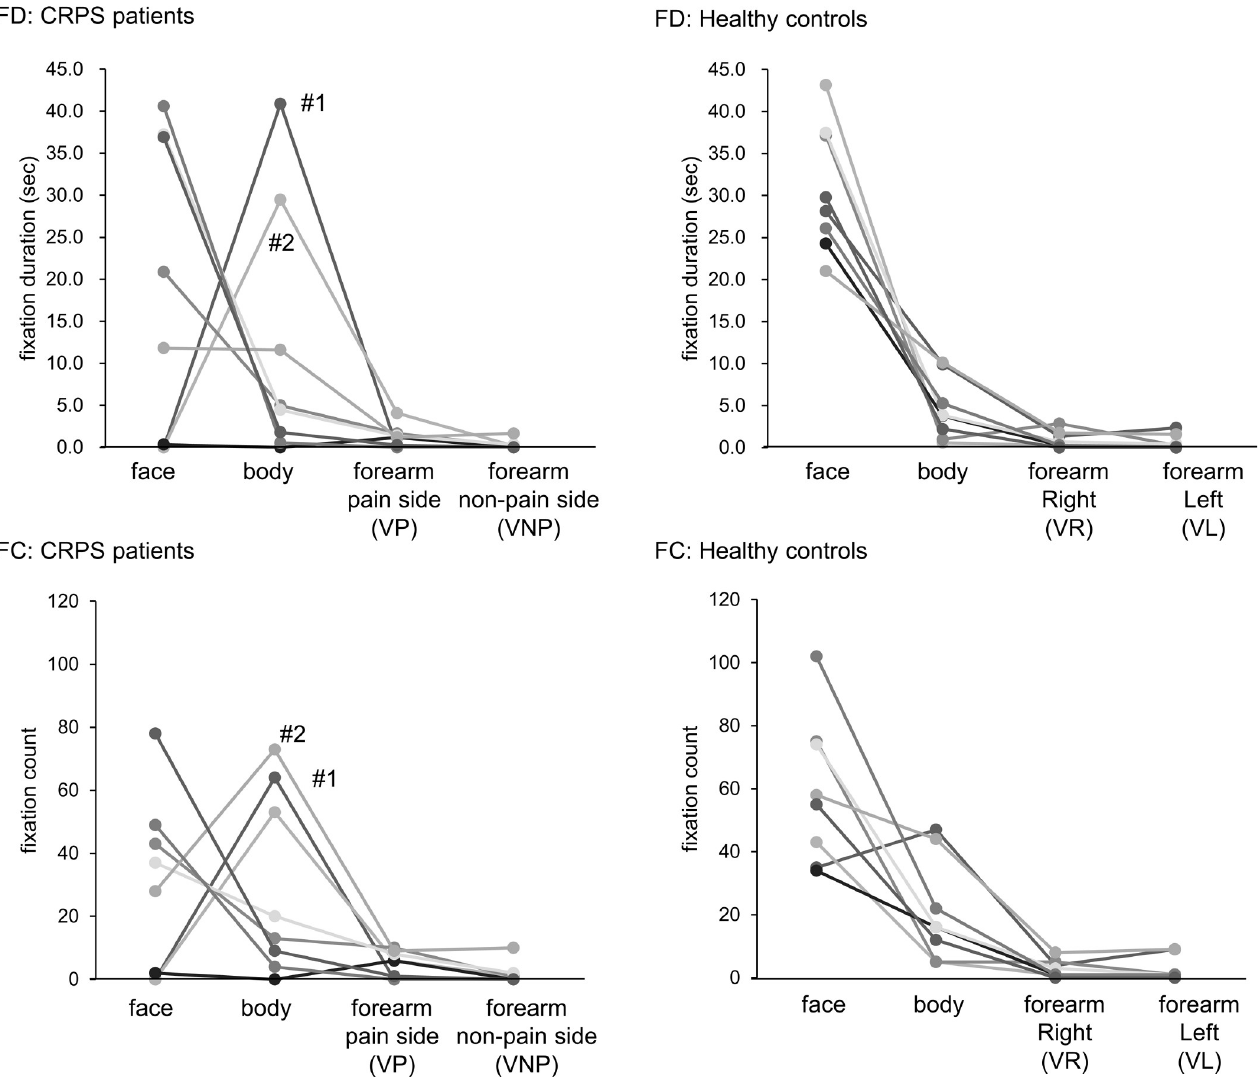
Fig 2. Individual data of visual attentional behavior while watching video clip 1. FD: fixation duration, FC: fixation count, VP and VNP: VP and VNP refer to the side of the person in video 1 corresponding to the painful and non-painful side of the patients. VR and VL: VR and VL refer to the right and left side of the person in video